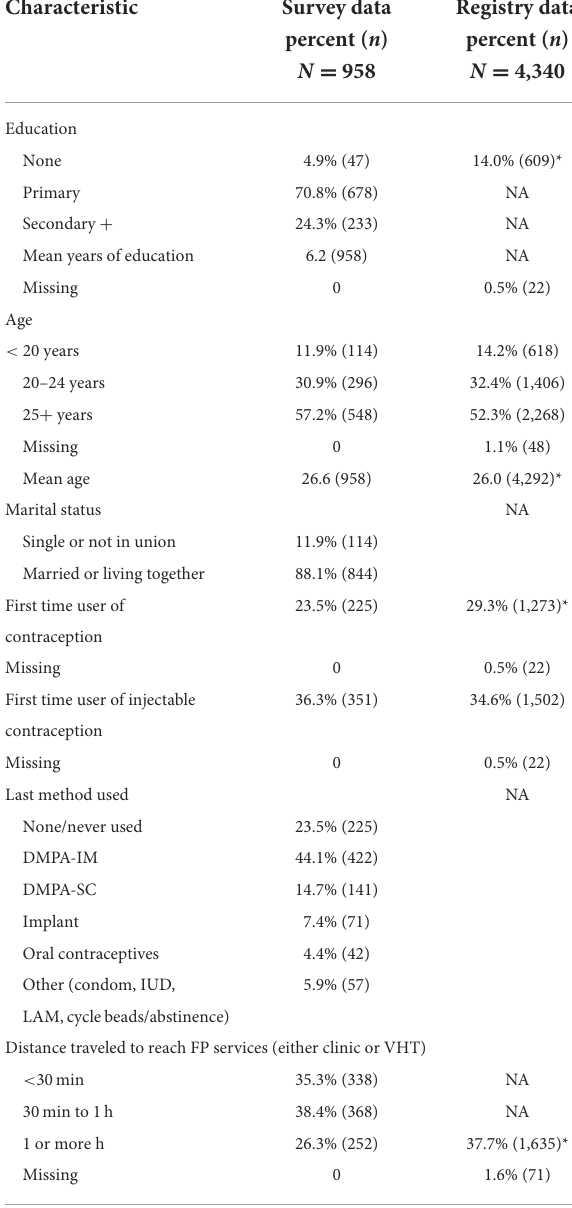
TABLE 1 Self-injection client background and family planning experience.